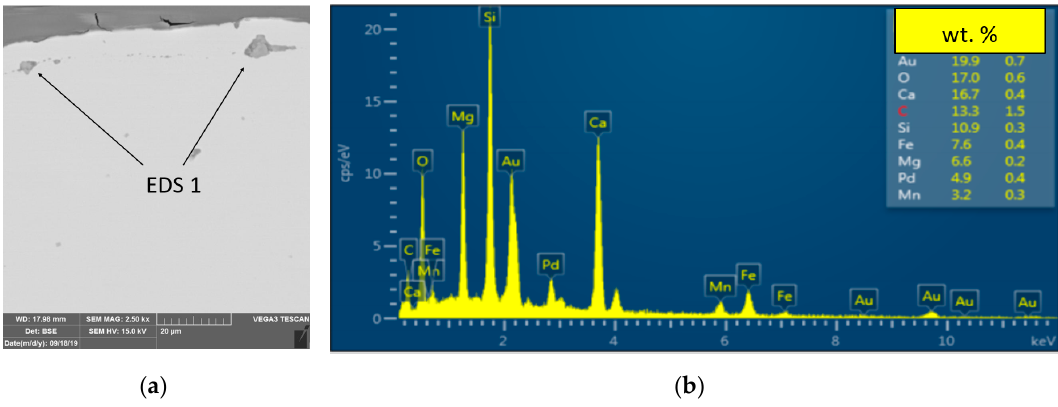
Figure 10. EDS , Energy-dispersive X-ray spectroscopy analyses of foreign fragments of samples: ( a )